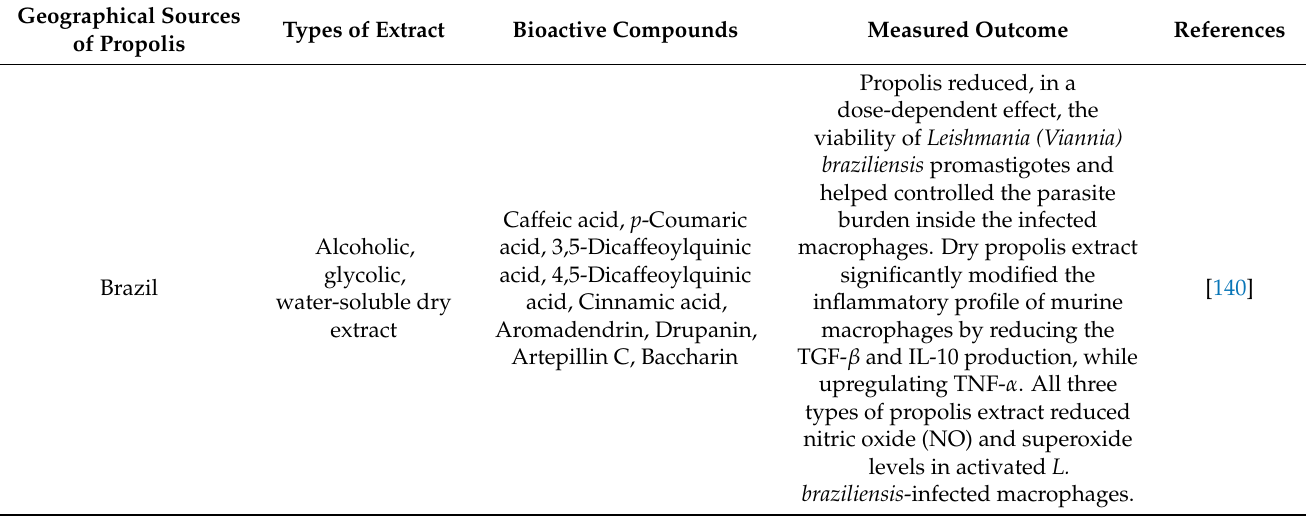
Table 6. Anti-inflammatory properties of propolis inpathogenic